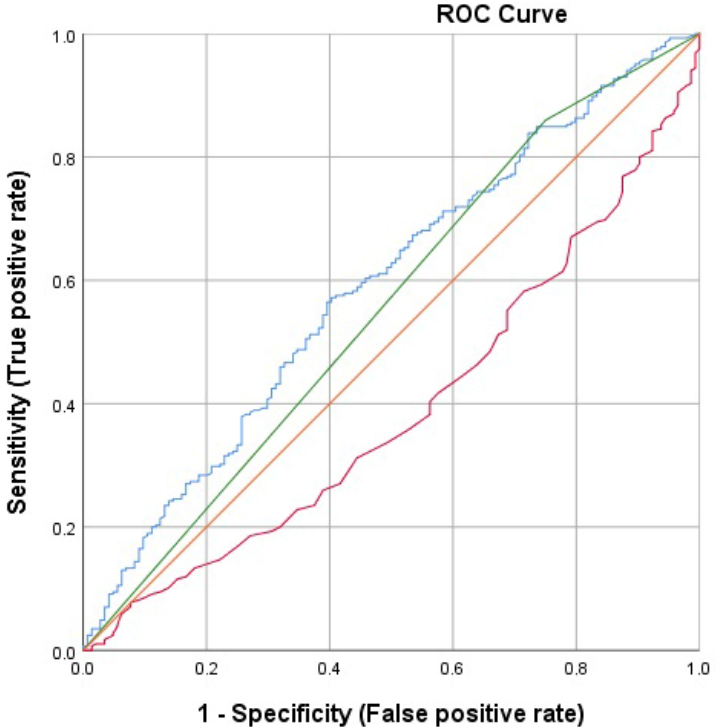
Figure 1. ROC curve for fibrinogen-to-albumin ratio (FAR), hemoglobin level (HB), and male gender. Diagonal segments are produced by ties. Reference line is the 45° diagonal line, serving as reference for a statistical test with no discriminatory ability.